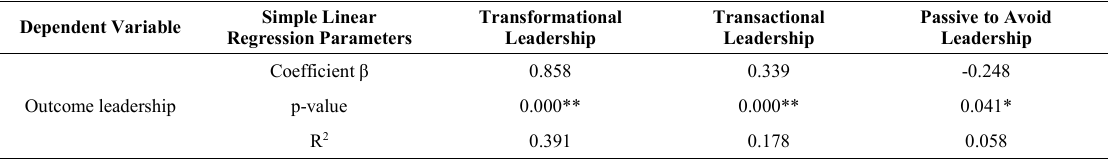
Table 8. Outcome Leadership vs. Leadership Types.